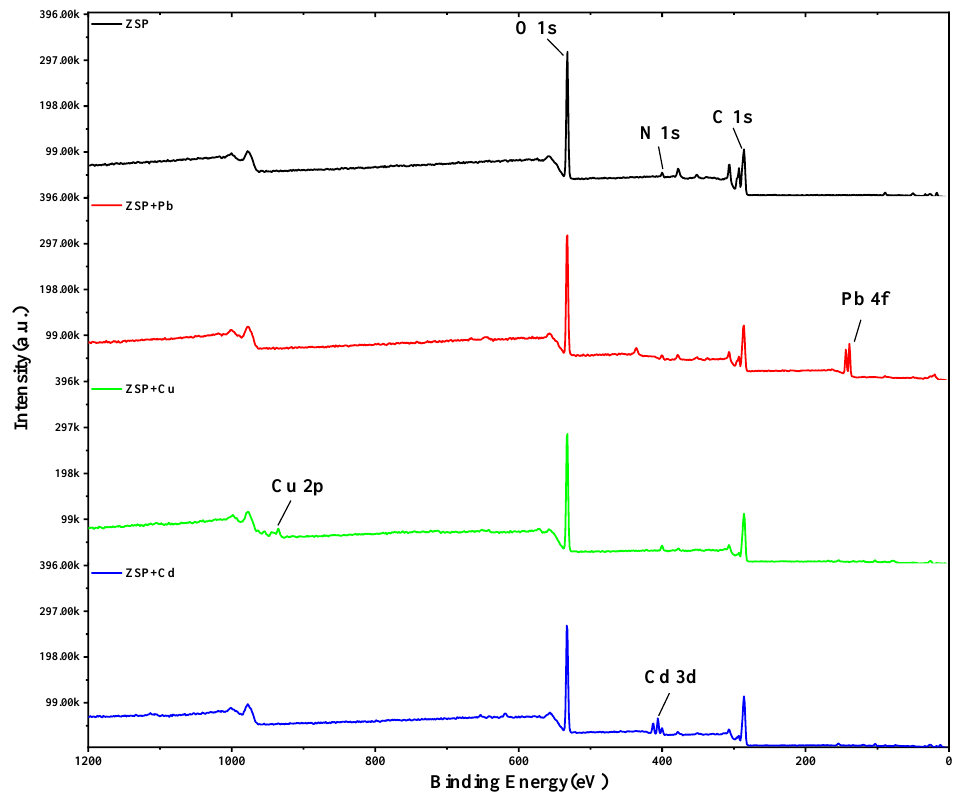
Figure 6. XPS broad scan spectra of ZSP before and after adsorption of Pb 2+ , Cu 2+ and Cd 2+ .